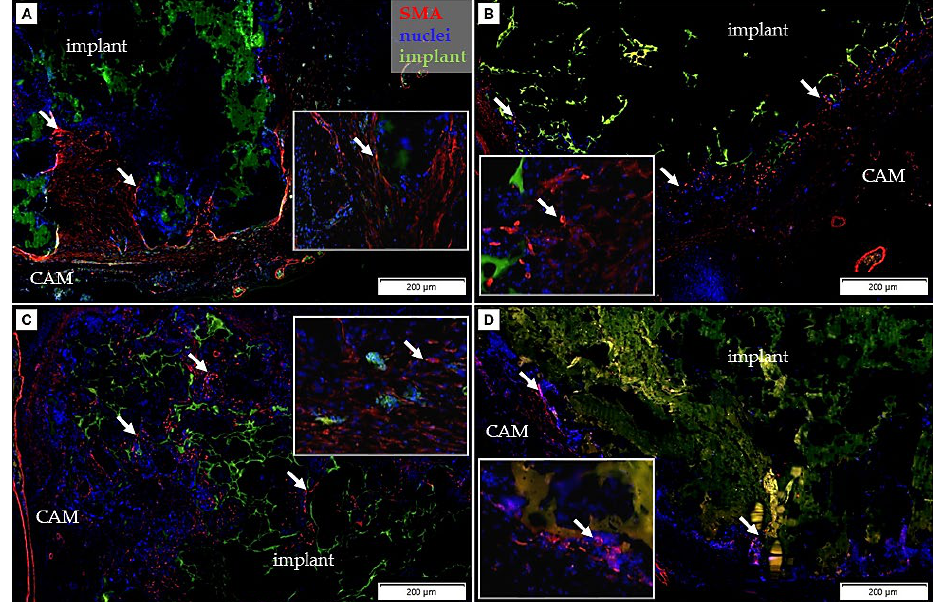
Figure 8. Immunohistochemical detection of the α -smooth muscle actin ( α -SMA) in the porous PHB/CHIT scaffolds. The presence of the myofibroblasts (arrow) was observed on a border between the scaffold and surrounding CAM tissue in all cases. The expression level of the α -SMA suggested presence of myofibroblasts in view to ongoing tissue repair; scale bar: 200 µ m; biological replicates (6 for each group), technical replicates (48 for each group).